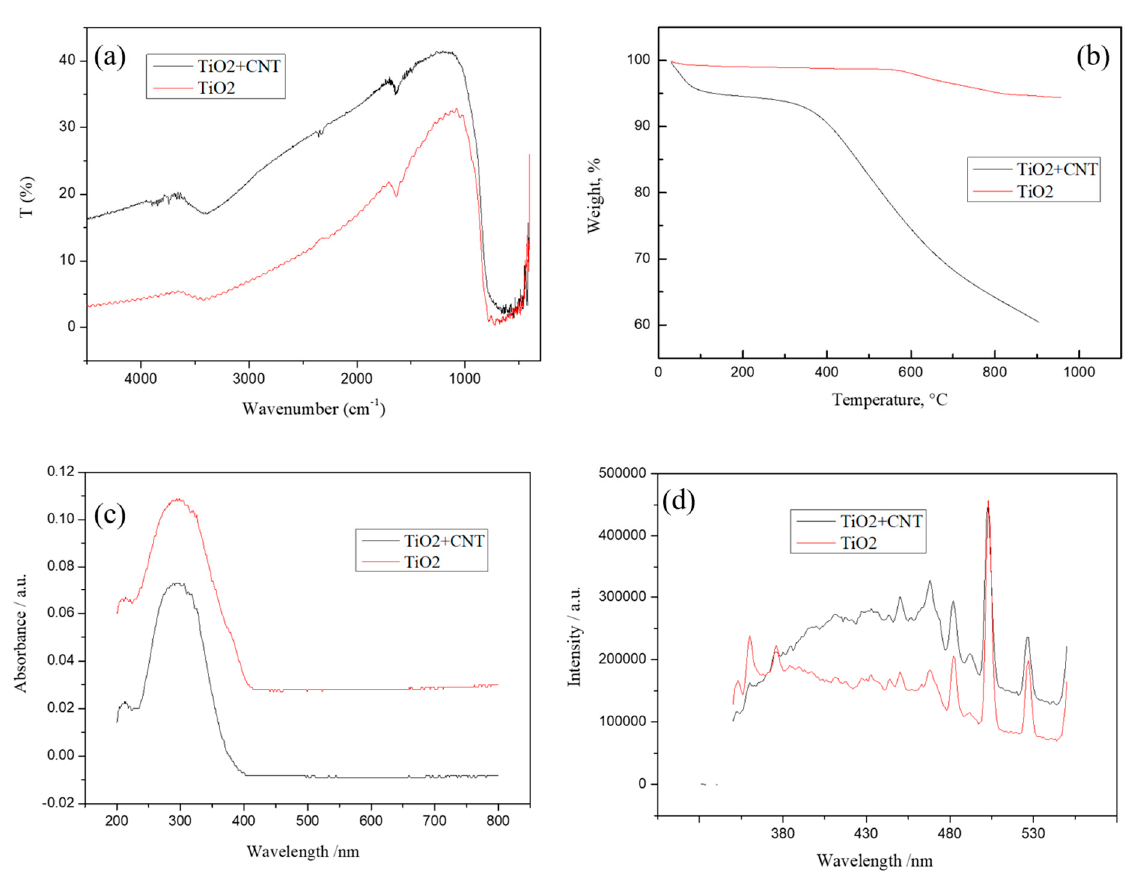
Figure 5. FT-IR spectra ( a ); thermogravimetric analysis ( b ); UV–vis ( c ) and photoluminescence spectra ( d ) of the TiO 2 + CNT mesoporous nanomaterials.